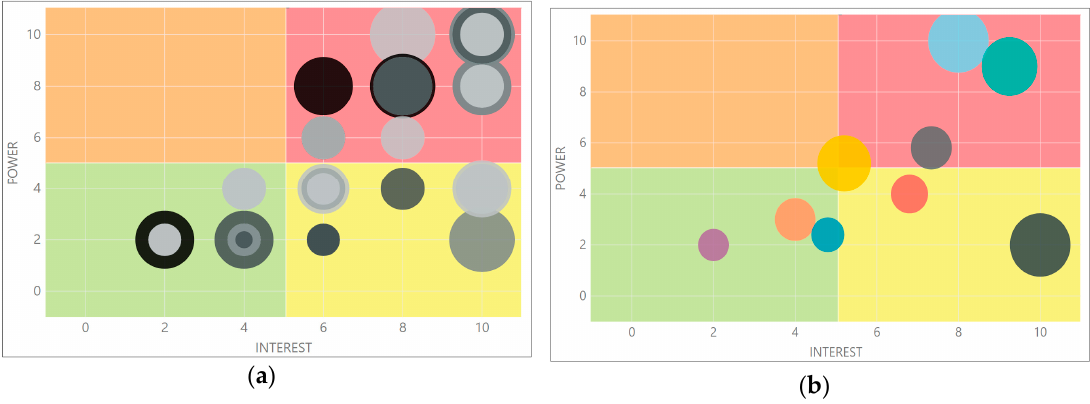
Figure 11. Representation of project nº 8 matrixes. ( a ) Representation of the power–interest matrix position, and impact and stability of the stakeholders. The names of the stakeholders are not relevant to show their distribution in the matrix. ( b ) Average value matrix of the power and interest variables.